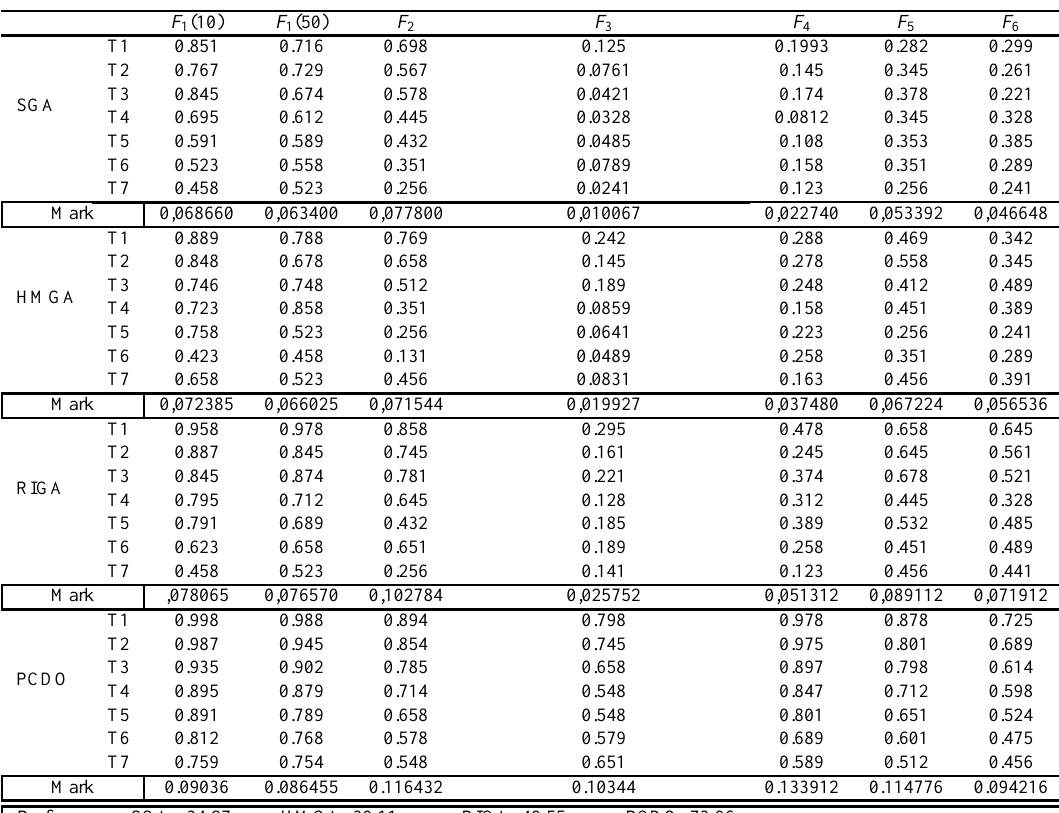
Table 7. Algorithm Overall